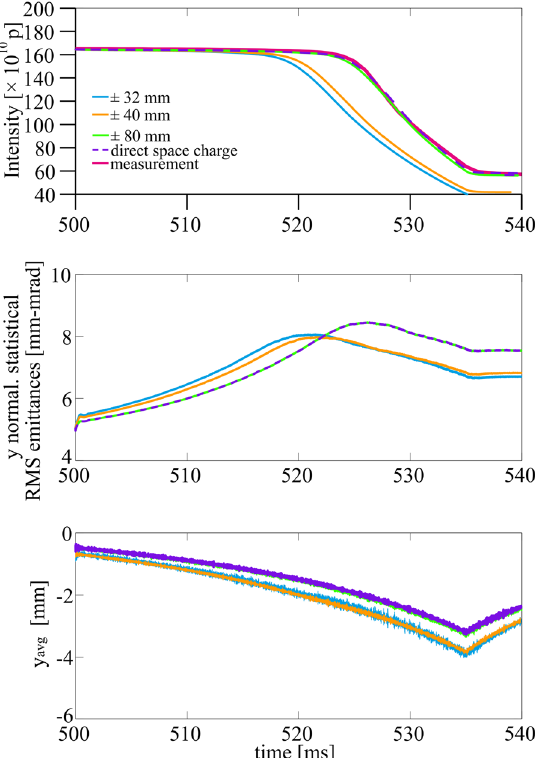
FIG. 27. Dynamic integer without COD correction: simulations with different chamber heights of intensity (top), normalized statistical emittance (center) and vertical centroid